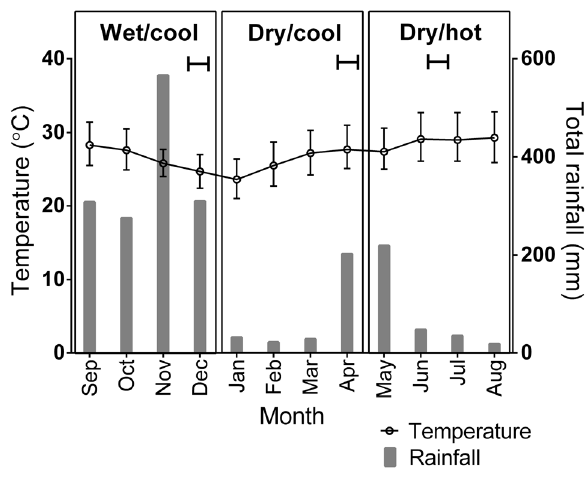
Figure 2. Macro-climatic conditions in Nha Trang, central Vietnam, during the three seasonal field experiments. Brackets indicate the period of semi-field and Tri Nguyen mosquito collections.